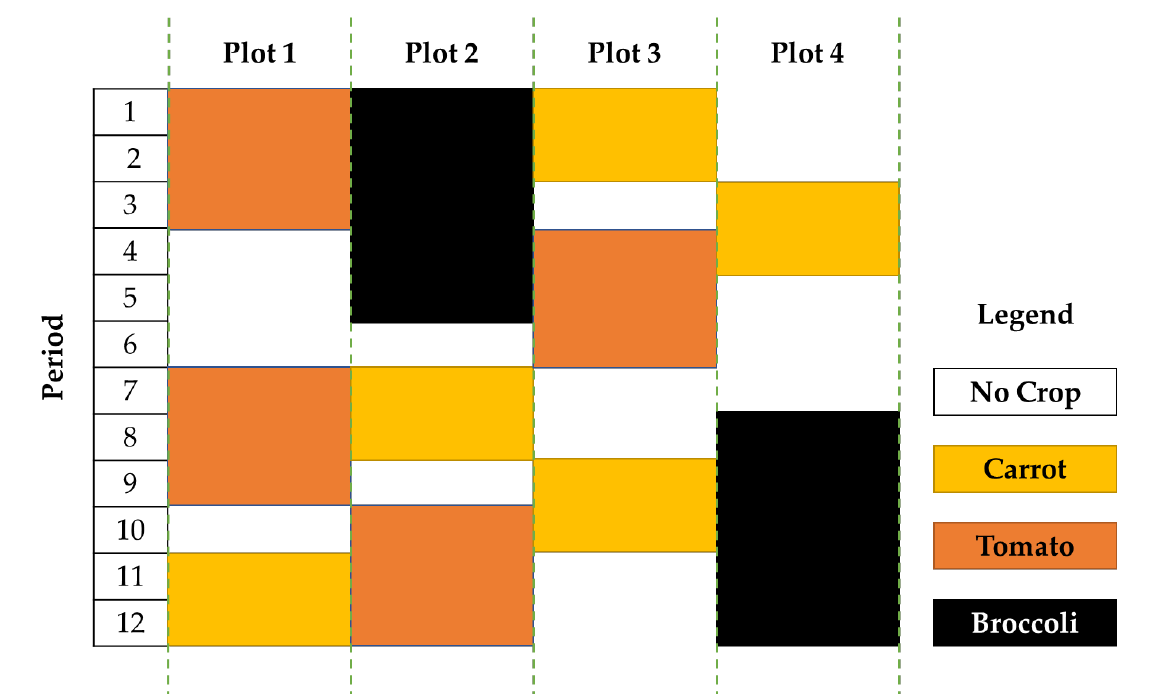
Figure 1. Representation of the solution obtained by GLPK for Case 1. On the first plot, tomato is cultivated twice and carrot once. On the second plot, Broccoli, tomato, and carrot are cultivated once. On the third plot, carrot is cultivated twice and tomato once. On the last plot, broccoli and carrot are cultivated once.